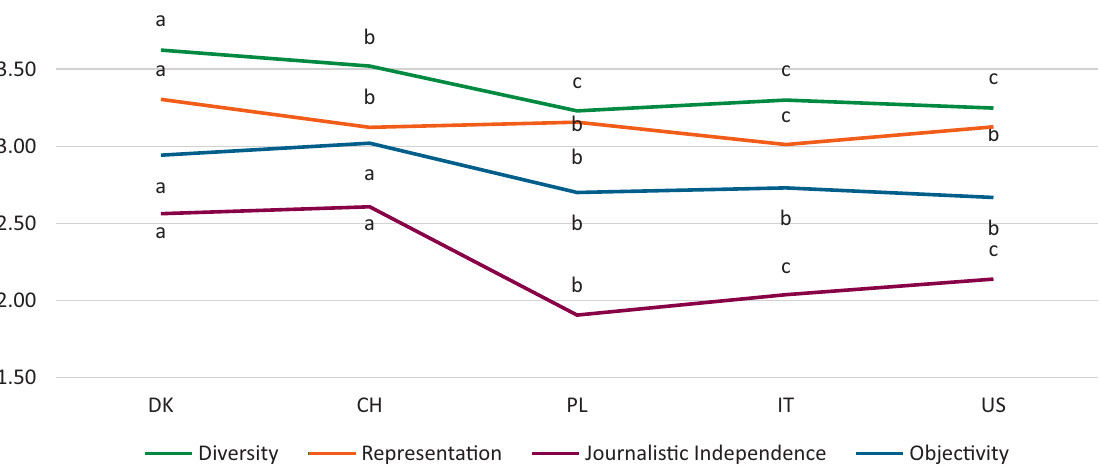
Figure 2. Countries differences in perceived news media performance by individual indicators. Note: Groups with different identification letters (a, b, c) are significantly different according to Bonferroni-corrected post hoc tests (p < .05). CH and DK with the most positive evaluations across all four indicators, and on the other hand, PL, IT, and the US with overall lower values on all four indicators.